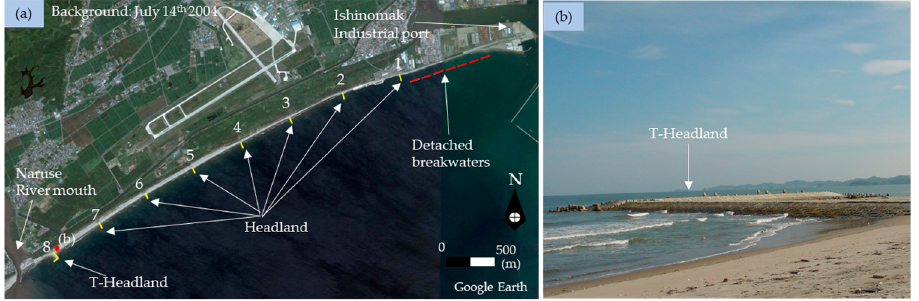
Figure 3. ( a ) Detached breakwaters and headlands along the Ohmagari Coast. ( b ) Closer view of the T-headland near the Naruse River mouth (Captured in 2014).